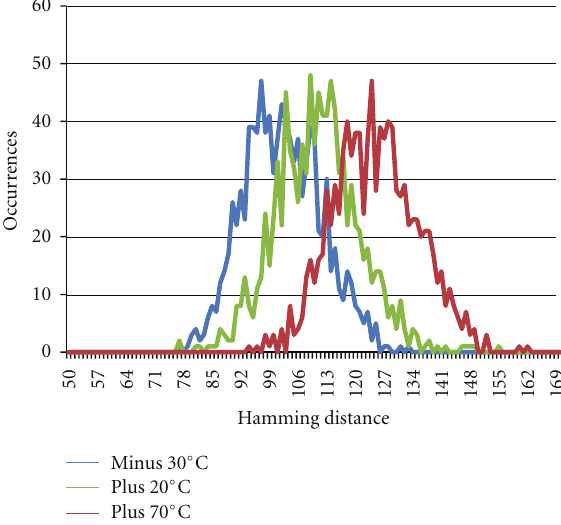
Figure 11: Hamming distance of single readback and masterbit- stream of board I at di ff erent temperatures.